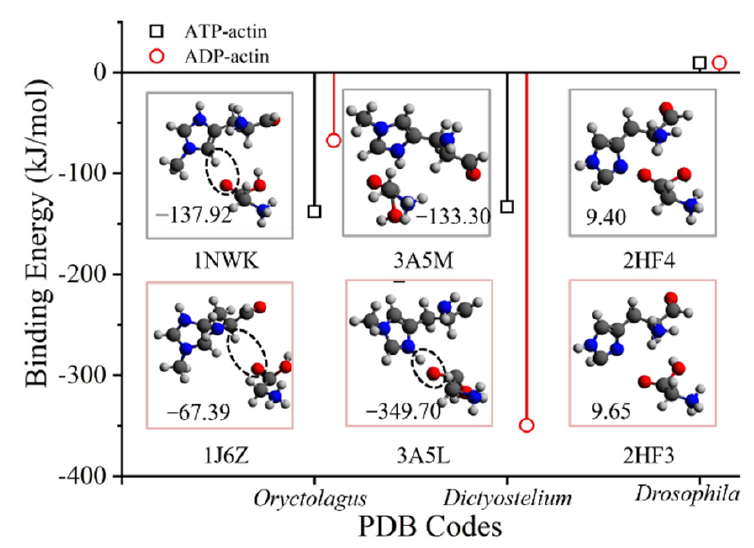
Figure 5. The weak chemical interaction between His73 and Gly158 for both ATP and ADP-actin. The binding energies for ATP-actin are not obligatorily lower than those for ADP-actin. H-bonds (dash circle) could not be found on all ATP-actin structures (PDB codes: 3A5M and 2Hf4), yet it appears in some ADP-actin structures (PDB codes: 1J6Z and 3A5L). The values in the conformation pictures denote the binding energy of the corresponding actin structure. Color key: O, red; C, gray; N, blue; H, silver.